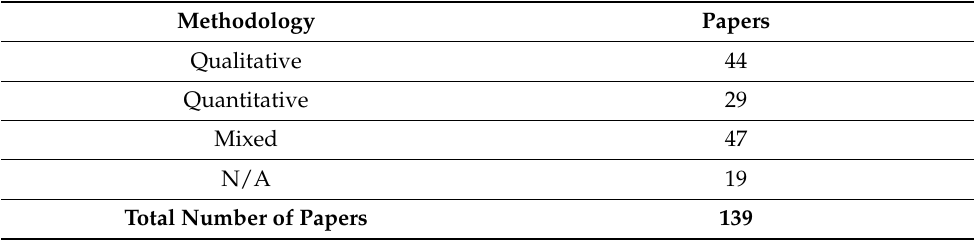
Table 5. Papers’ methodologies.